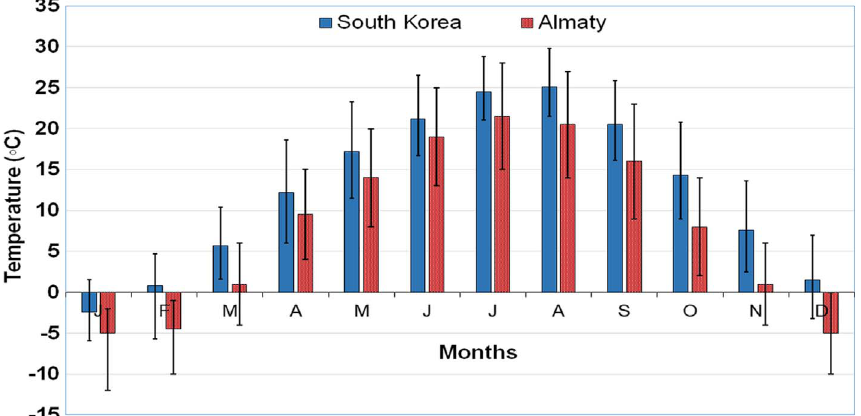
Figure 2. Comparison of the mean monthly temperatures at Almaty (Kazakhstan) and South Korea over 20 years. Vertical coloured lines in the upper part denote mean maximum temperatures ( (cid:3) C) over the considered period and in the lower part, mean minimum temperatures ( (cid:3)